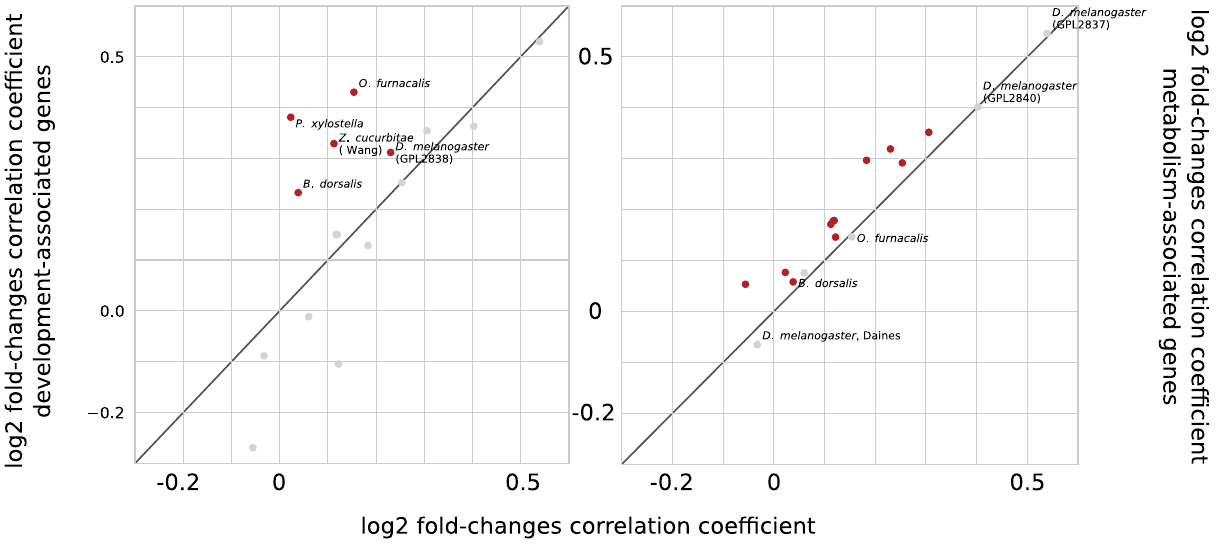
Figure 5. Correlation between transcriptome transitions from the embryo to the larva and from the pupa to the adult for all species. The correlations are calculated on the entire dataset (horizontal axis), the development- associated subset (according to gene ontology, vertical axis, left) and the metabolism-associated subset (vertical axis, right). Dots corresponding to the datasets with the statistically significant correlation coefficient are shown in red. Diagonal shows no changes in correlation coefficient when considering a gene subset instead of all